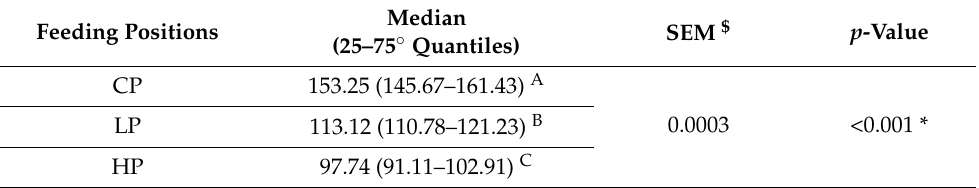
$ Mean standard error of BoxCox transformed values; * statistical significance; A–C values within a column annotated with different superscript letters are significantly different ( p ≤